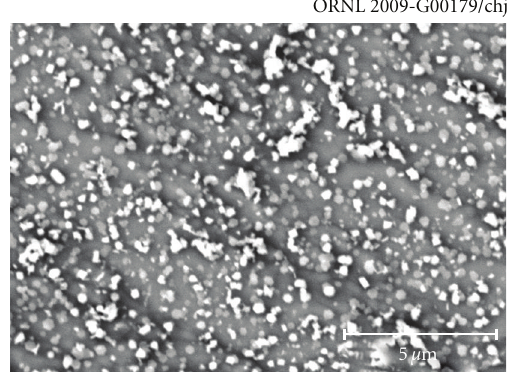
Figure 8: Early-onset growth of small metallic zinc particles on the single-crystal ZnO electrode surface. The cell operation/reduction time was